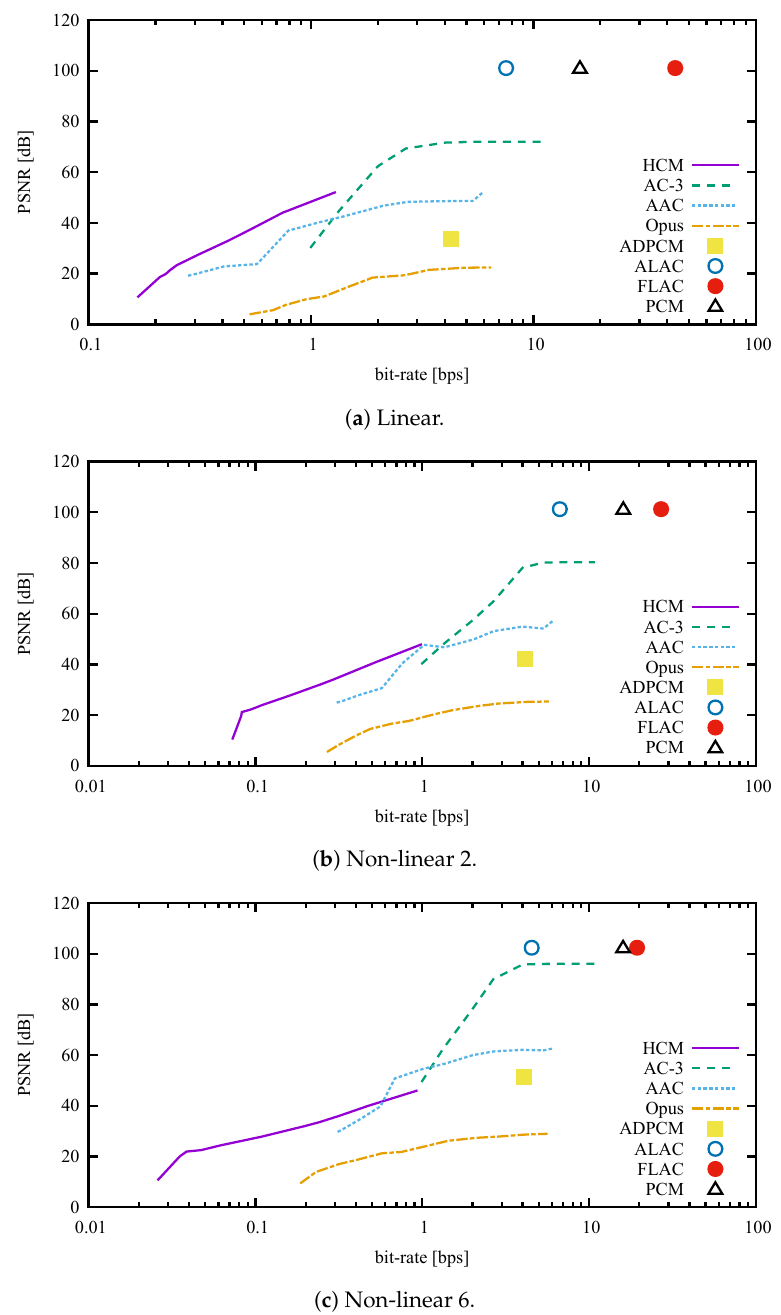
Figure 4. A relationship between the average bit rate and the corresponding peak signal-to-noise ratio (PSNR) for testing datasets: ( a ) Linear with one harmonic, ( b ) Non-linear 2 with two harmonics, and ( c ) Non-linear 6 with six